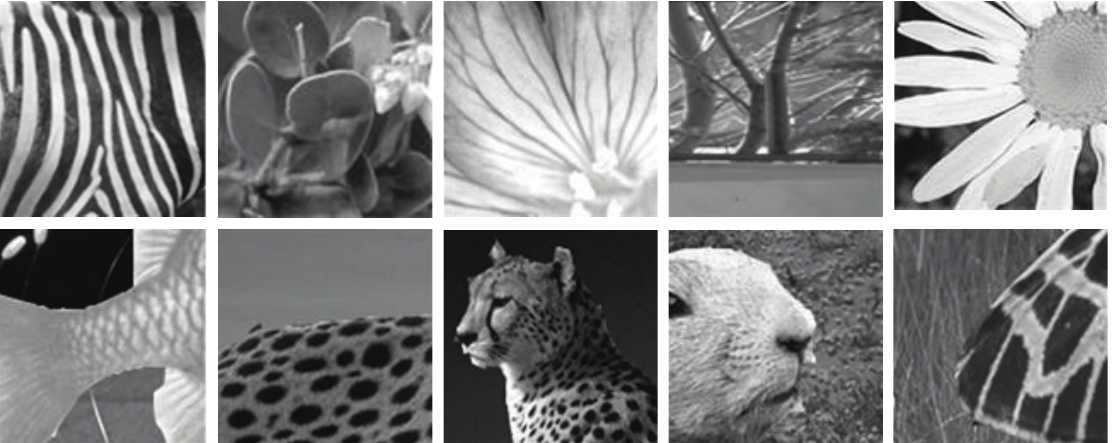
Figure 3: Examples of DVMM image dataset.